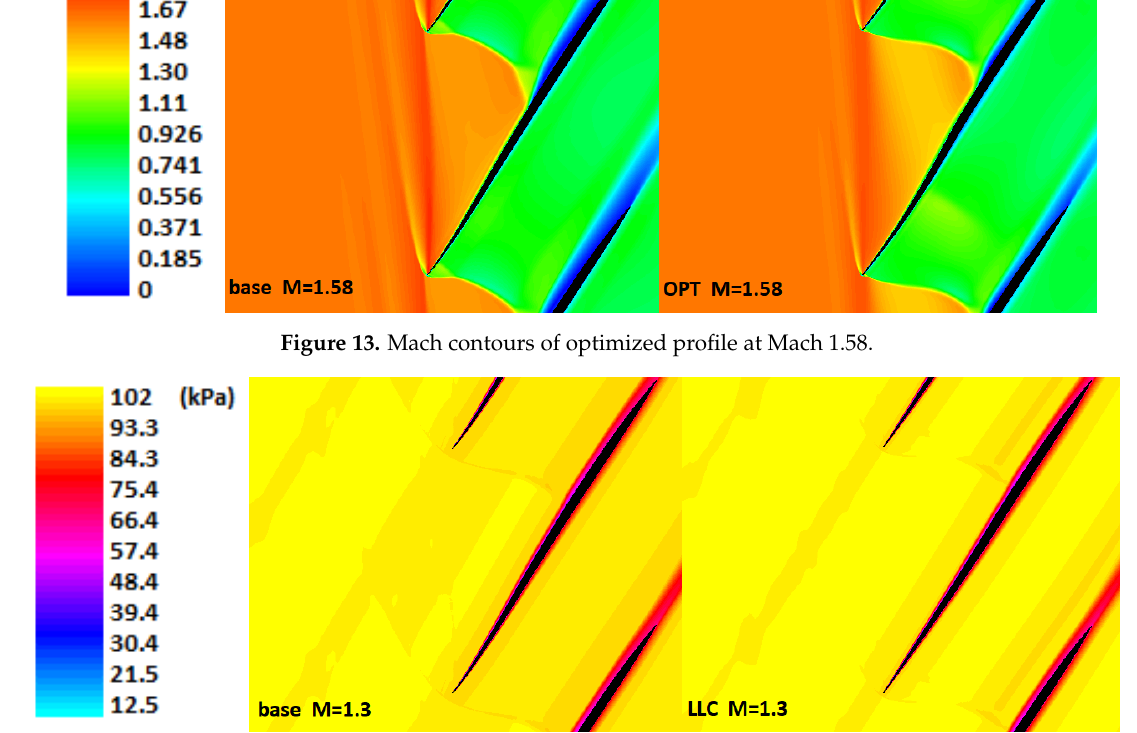
Figure 14. Total pressure contours (kPa) of profiles with LLC at Mach 1.3.